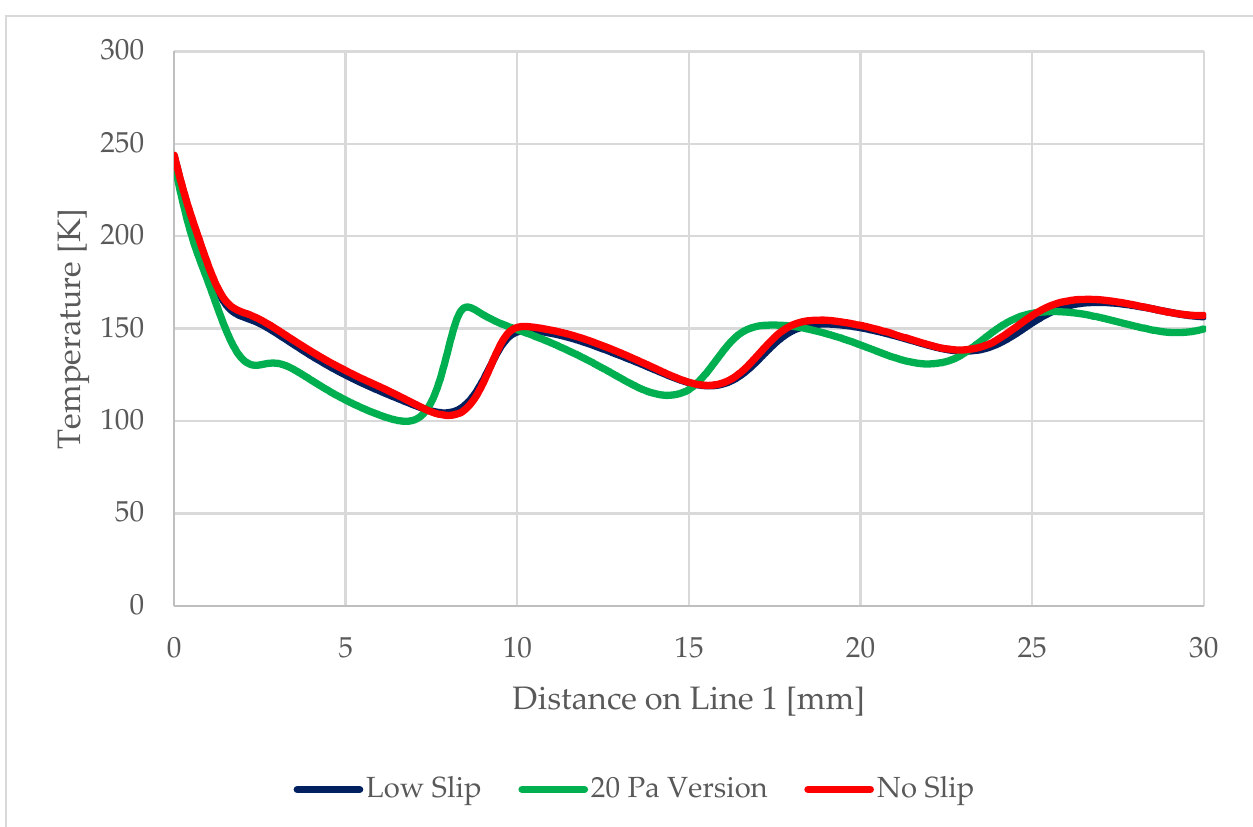
Figure 21. Mach number distribution.